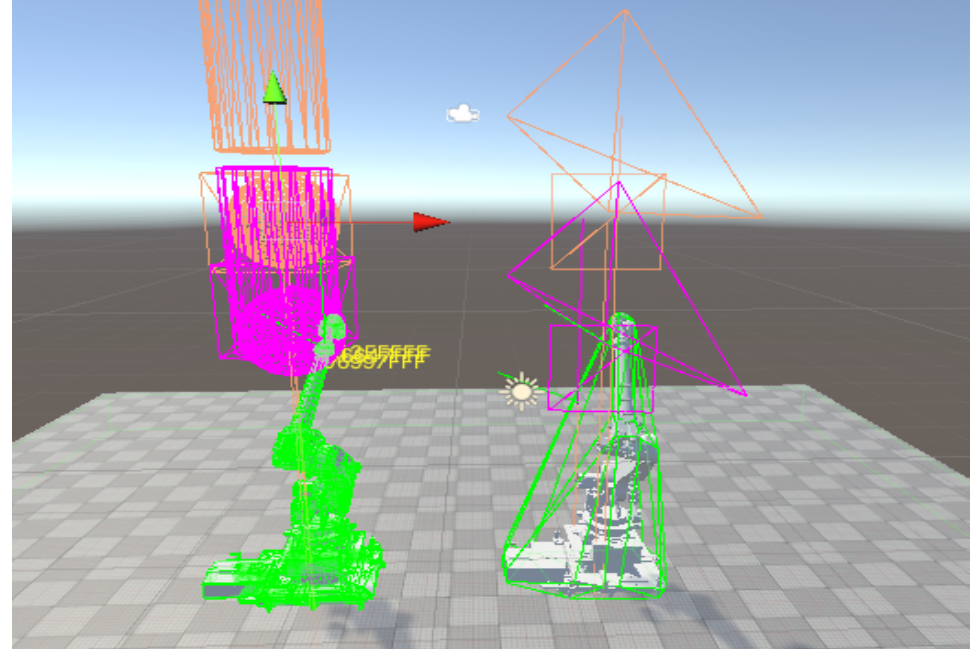
Figure 15. Physical engine simulation of unity physics and Havok